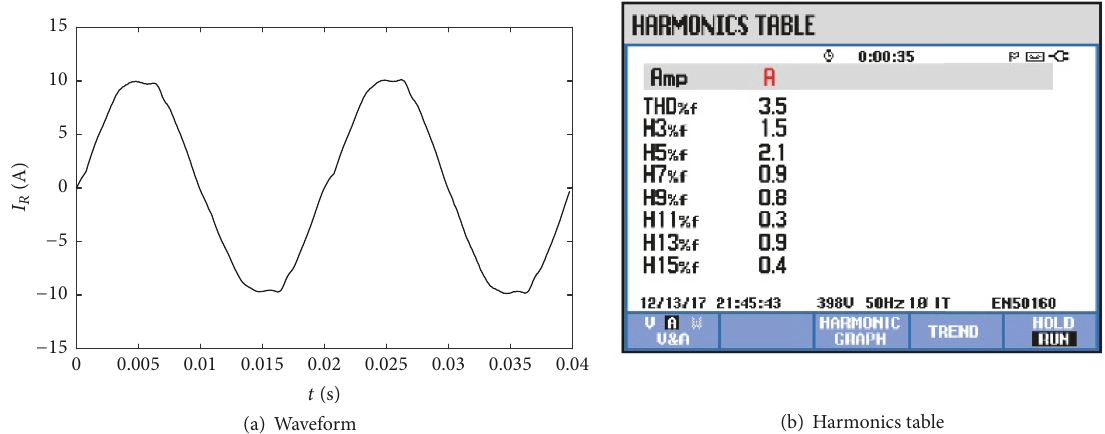
Figure 9: Waveform and harmonics table of current on ac side with multiresonant control strategy.